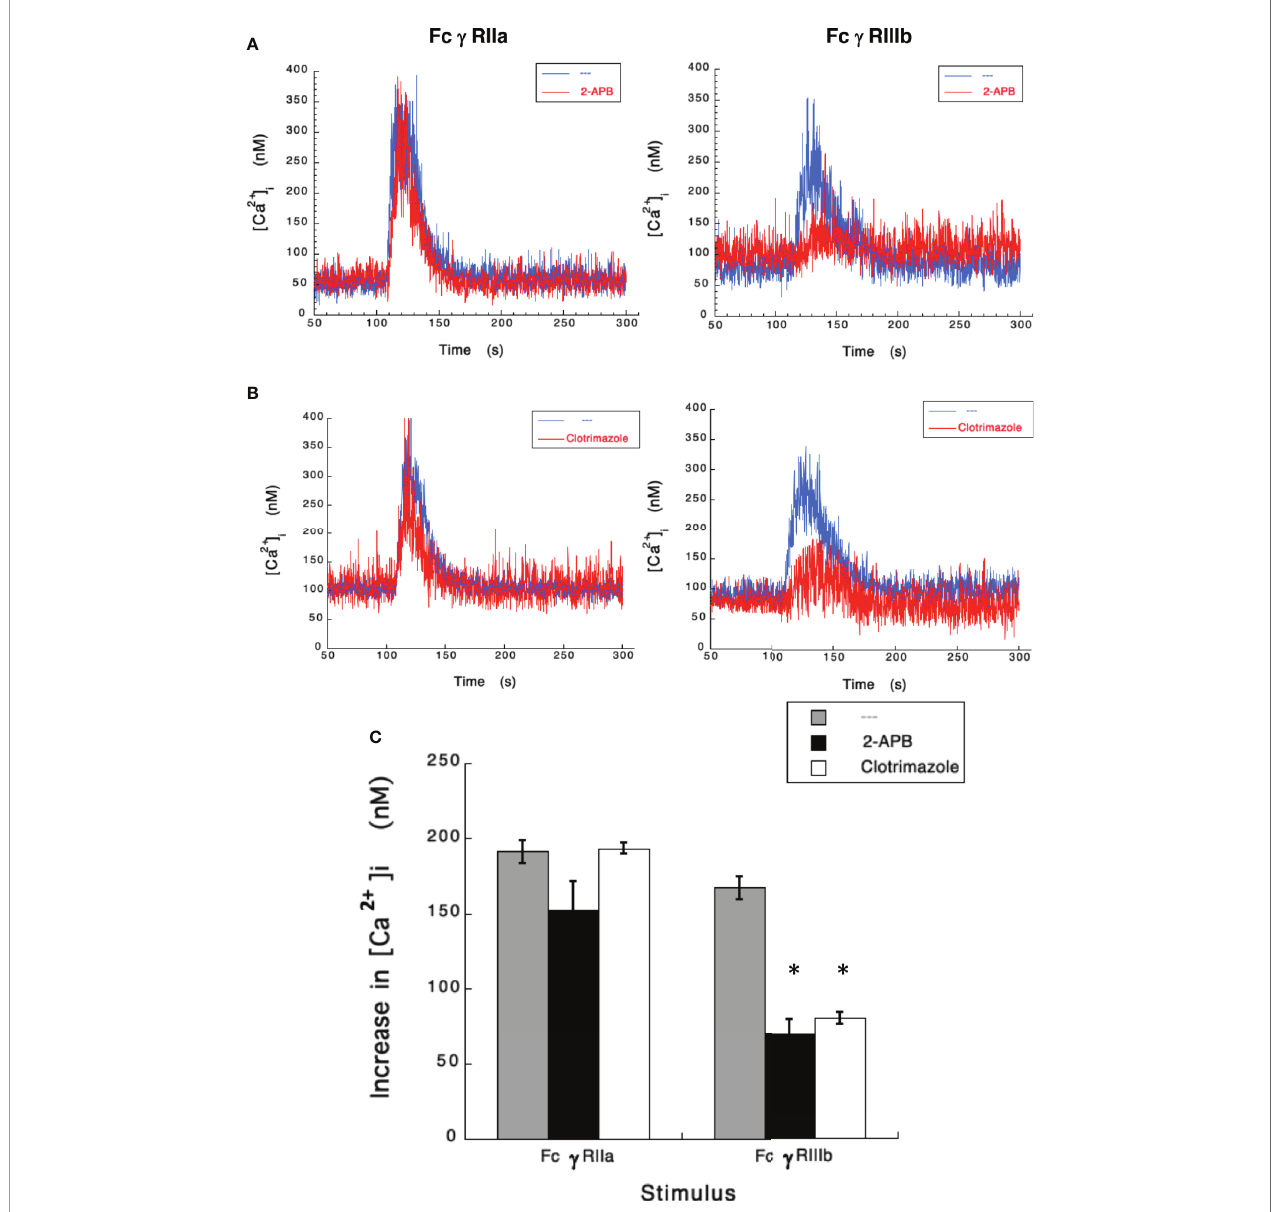
FIGURE 5 | TRPM 2 channel mediates Fc g RIIIb-induced increase in [Ca 2+ ] i . Fura-2-loaded human neutrophils in PBS with Ca 2+ and Mg 2+ were left untreated (blue line), or treated (red line) with 5 µM 2-APB (A) or with 10 µM clotrimazole (B) , two TRPM2 inhibitors, before being stimulated by aggregating Fc g RIIa or Fc g RIIIb. Changes in cytosolic calcium concentration ([Ca 2+ ] i ) were assessed by measuring the variations in fl uorescence as described in material and methods. Tracings are representative of three experiments with similar results. (C) Increments in [Ca 2+ ] i were calculated by subtracting the baseline value from the maximum value after stimulation. Data are mean ± SEM of three independent experiments. Asterisks (*) denote conditions that were statistically different from untreated cells (p <